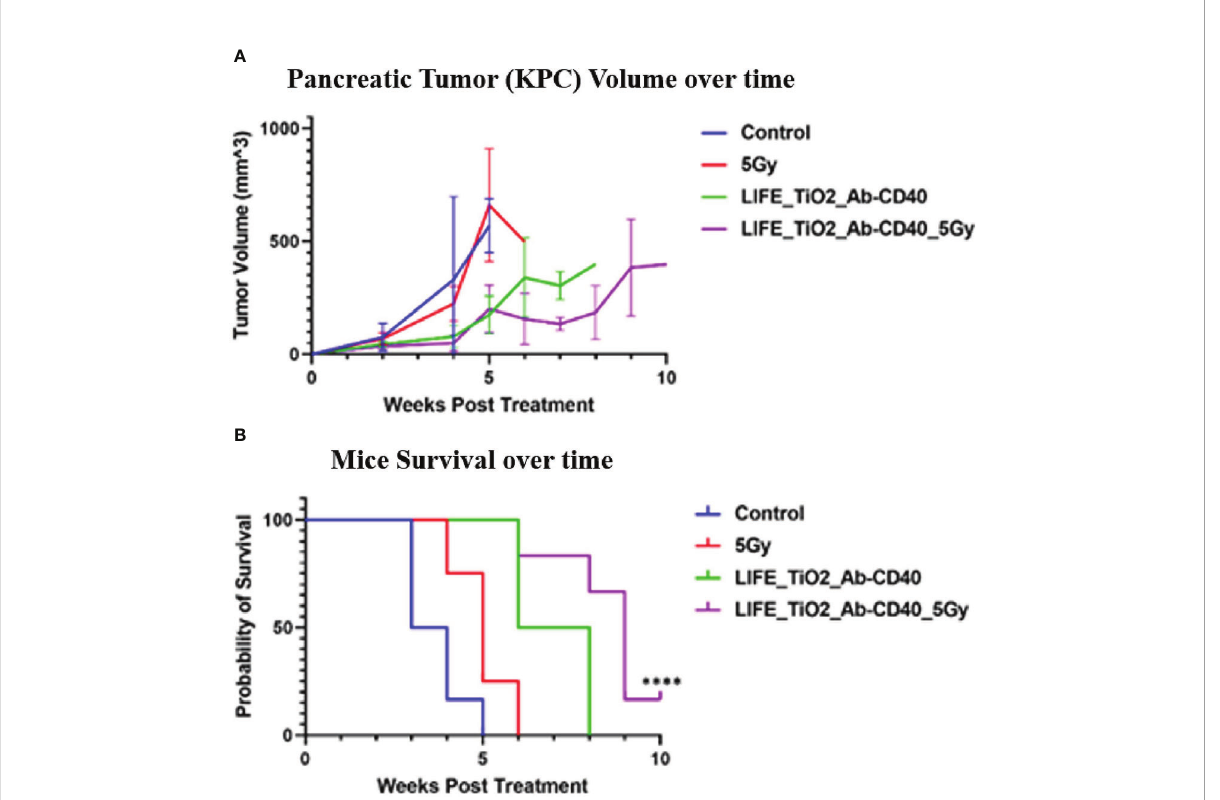
FIGURE 4 Mice tumor volume (A) and survival (B) were assessed for up to 10-weeks post treatment. Treatment was administered when tumor diameter reached ~4mm. The cohorts of mice investigated were: 1) control (n =6) received no treatment, 2) Radiotherapy dose of 5Gy, 3) mice treated with LIFE_TIO 2 biomaterial loaded with 20ug of Ab-CD40, and 4) mice treated with LIFE_TIO 2 biomaterial loaded with 20ug of Ab-CD40 exposed to 5Gy of radiation. Slowed tumor growth was observed for cohorts treated with LIFE_TiO 2 _Ab-CD40 with/without 5Gy. However, mice survival appeared most favorable for cohort treated with LIFE_TiO 2 _Ab-CD40_5Gy compared to control as indicated by the symbol '****' corresponding to p-value <